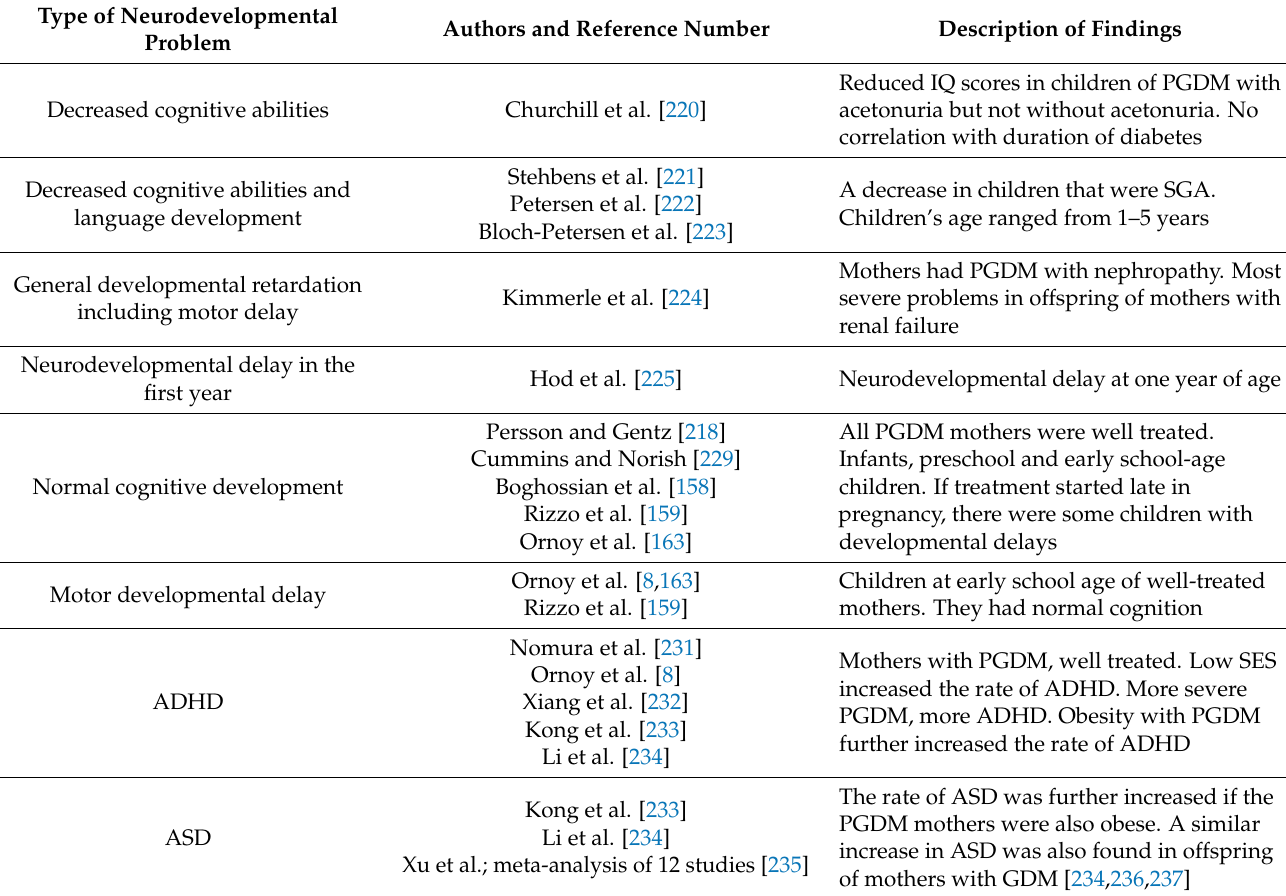
Table 4. Neurodevelopmental problems in children born to mothers with